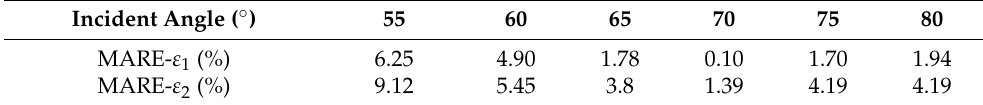
Table 1. MARE values of the dielectric functions at different incident angles.